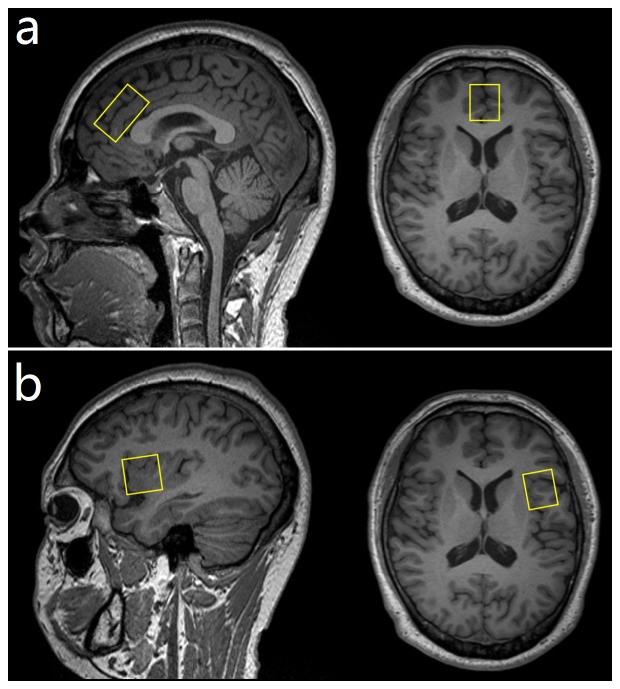

T
1-weighted images depicting voxel placement in the ACC (a) and the left AI (b) of a representative participant.Voxel dimensions: ACC, 20 mm (RL)×18 mm (AP)×30 mm (FH); AI, 20 mm (RL)×25 mm (AP)×25 mm (FH).